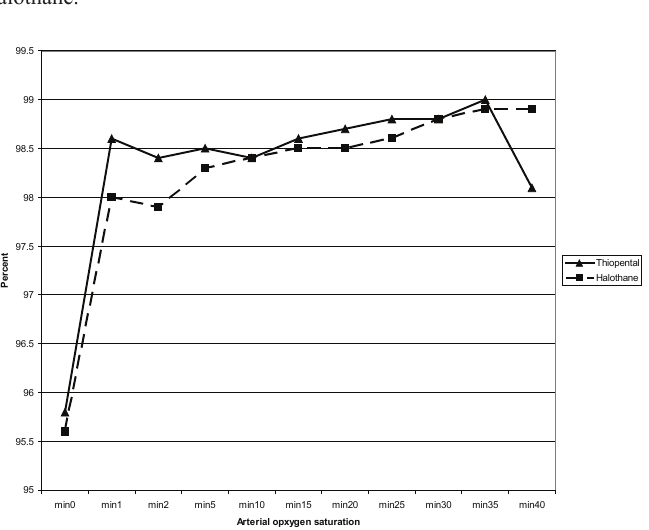
FIGURE 3 - Arterial O and